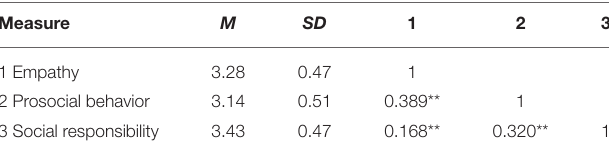
TABLE 1 | Descriptive statistics and Pearson correlations for all measures. Measure M